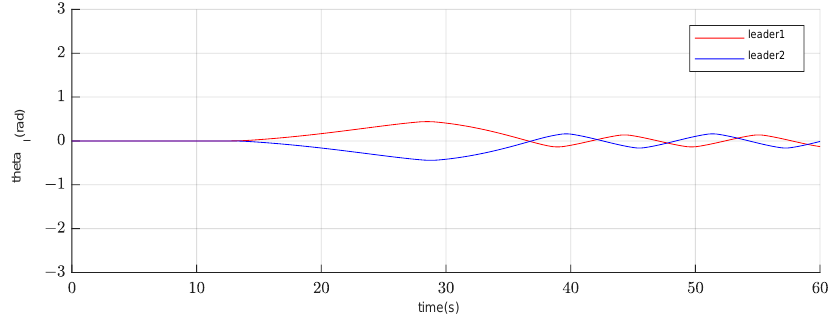
for the leaders during the movement. 𝜔𝜔 𝑙𝑙